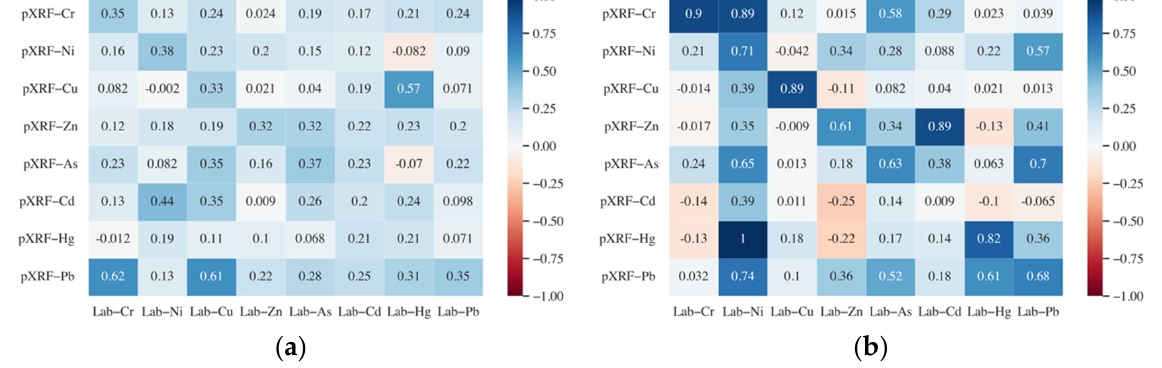
MARS model; Table S6: Validation statistics for predictive results of heavy metals of sample in pXRF high-value dataset using univariate LR model and MARS